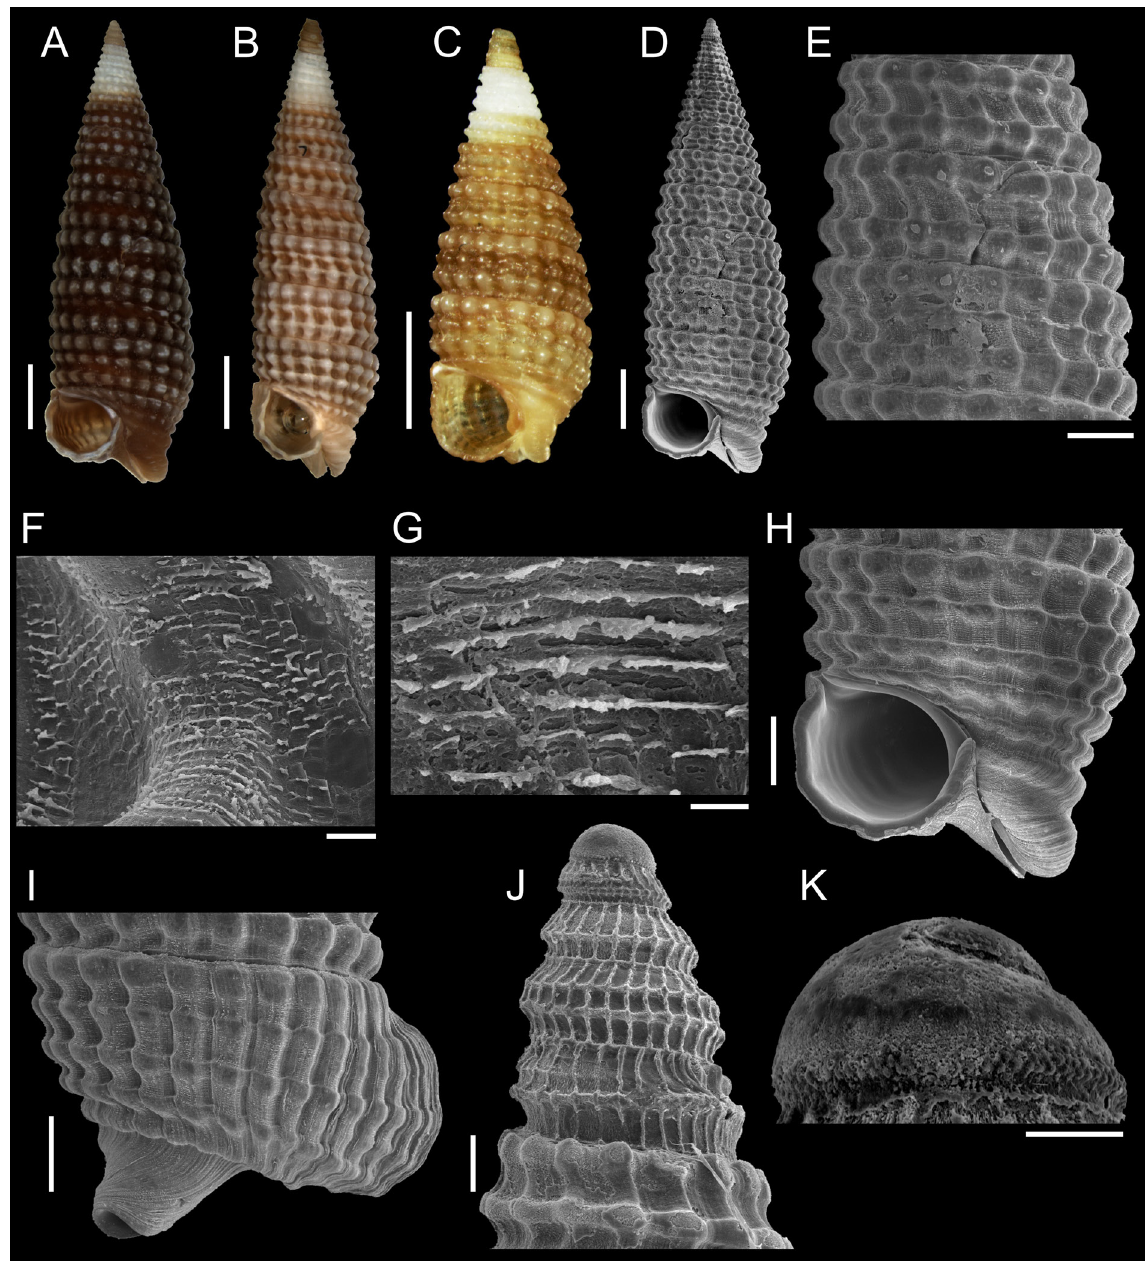
Fig. 19. Coriophora novem (Nowell-Usticke, 1969). A . MNRJ 18754*, 7.35 mm. B . MNRJ 18963*, 6.24 mm. C . MNRJ 29366*, 3.73 mm. D–K . Same shell as A (F–G: micro-spiral sculpture in the teleoconch). Scale bars: A–D = 1 mm; E, H–I = 500 µm; F, K = 50 µm; G = 20 µm; J = 100